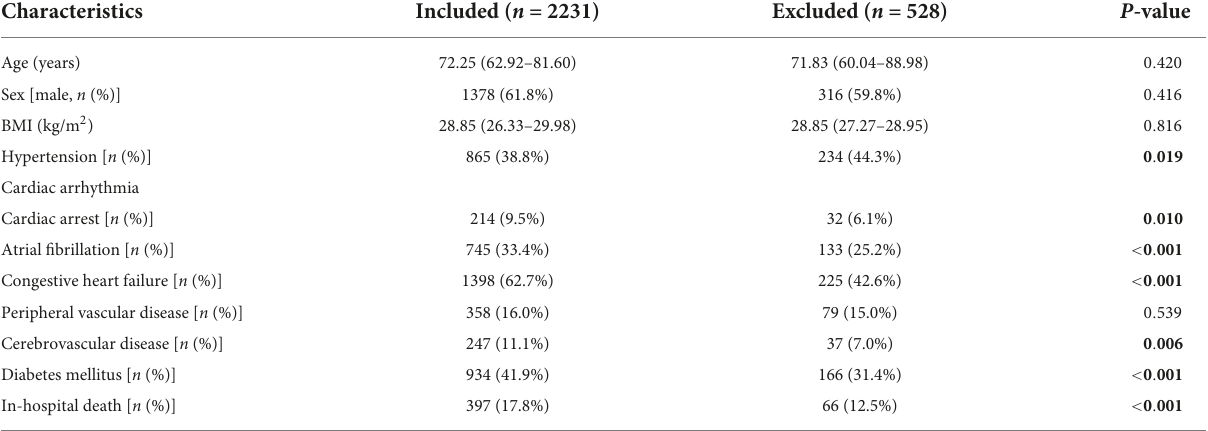
TABLE 1 Comparison of baseline clinical characteristics between included and excluded